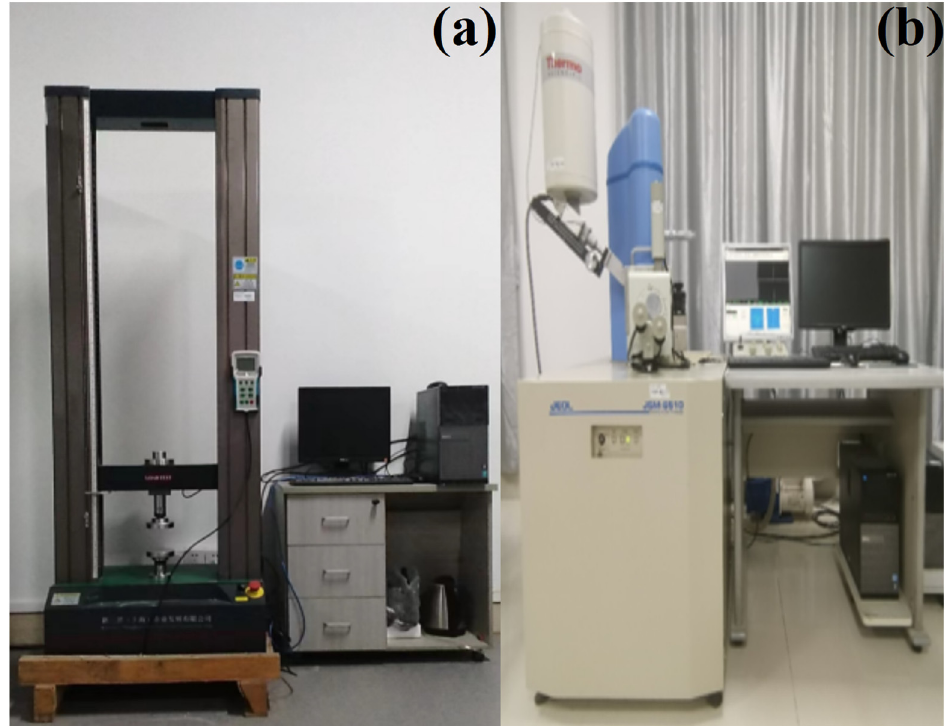
Figure 2. Experimental apparatus. ( a ) Universal testing machine, ( b ) Scanning Electron Micro- scope.